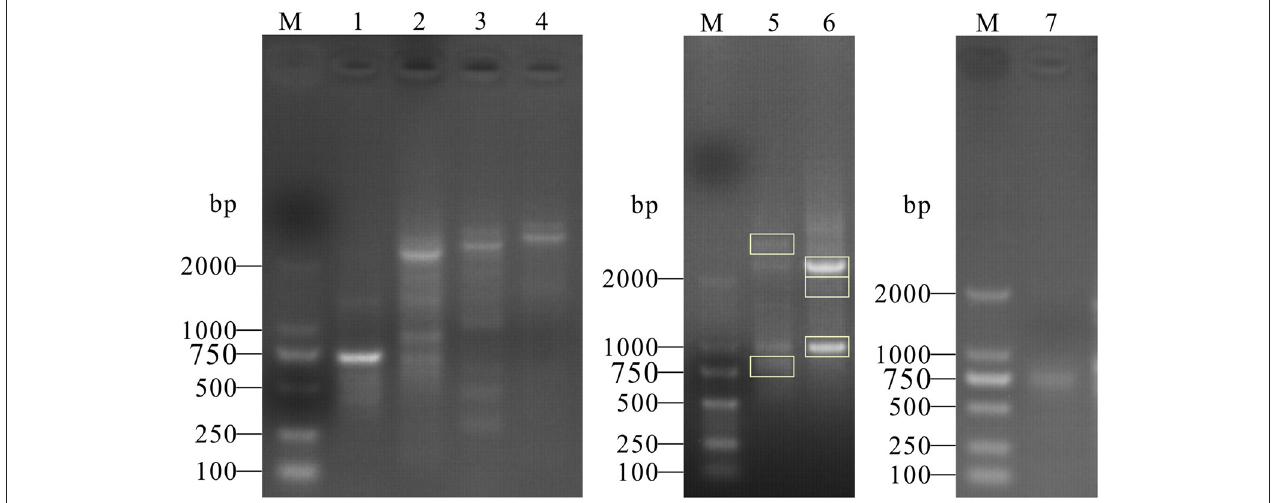
FIGURE 1 | PCR products of 3 ′ and 5 ′ RACE of the porcine PML gene. M: DL2000 Marker; the marker fragment sizes were 100, 250, 500, 750, 1,000, and 2,000 bp. Lanes 1, 2, 3, 4: PCR products of the first 3 ′ RACE cycle. Labels on the lanes represent different groups of 3 ′ RACE primers (3 ′ Race-GSP1, GSP2, GSP3, and GSP4). Lanes 5, 6: PCR products of the second 3 ′ RACE cycle (3 ′ Race-GSP2 and 3 ′ Race-GSP3 first-step PCR products as 3 ′ RACE-Ready cDNA), and gel bands in the rectangular box were selected for cloning analysis. Lane 7: PCR products of the first 5 ′ RACE cycle.